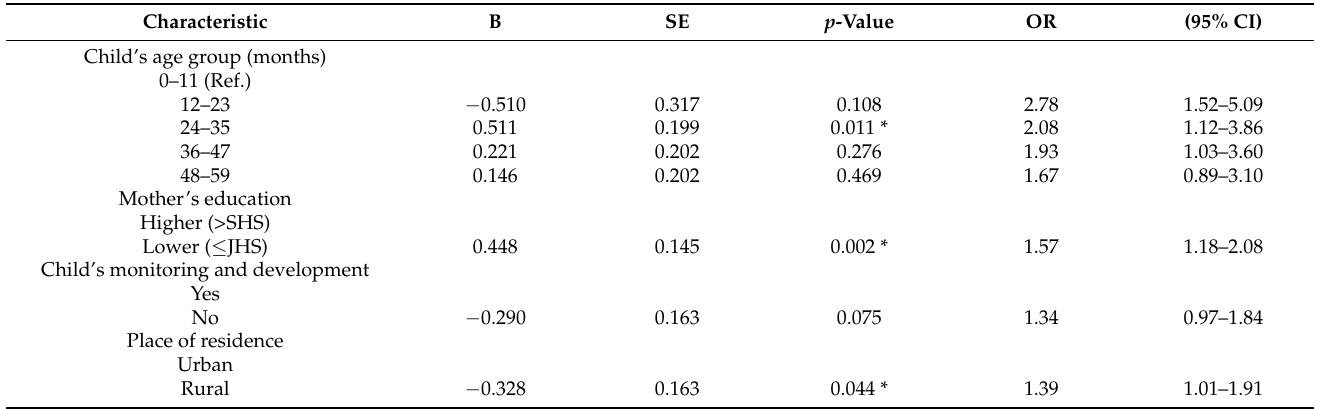
Table 3. The final model of the related factors of stunting incidence in